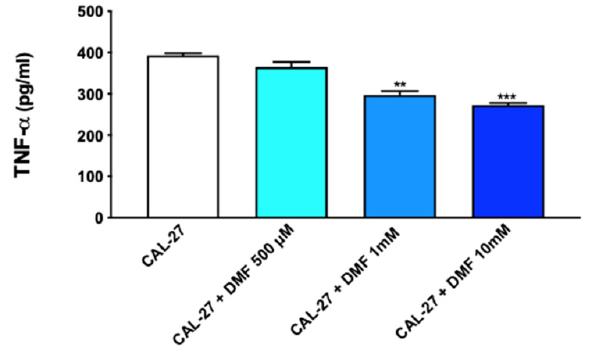
Figure 6. Effect of DMF on TNF α expression in CAL27 cell lysates. The enzyme-linked immunosor- bent assay (ELISA) revealed a significant decrease of TNF α expression following DMF treatment at the concentration of 1 mM and 10 mM. ** p < 0.01 svs. CAL27, *** p < 0.001 vs.